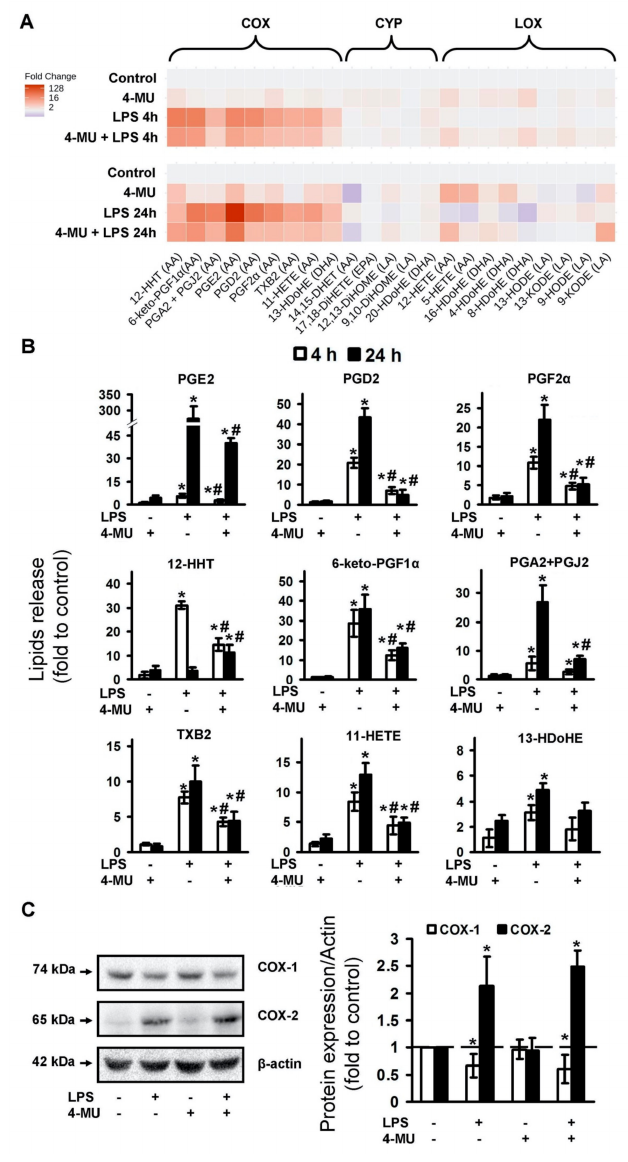
Figure 2. E ff ect of 4-methylumbelliferone (4-MU) on the oxylipins release and cyclooxygenases expression in the LPS-stimulated astrocytes. Primary rat astrocytes were pretreated for 30 min with 4-MU (400 µ M) and then stimulated with lipopolysaccharide (LPS, 100 ng / mL) for 4 h or 24 h. Concentrations of oxylipins in supernatants were measured using ultra-performance liquid chromatography-tandem mass spectrometry (UPLC-MS / MS). ( A ) The heat map shows relative amounts of each lipid mediator compared to the control. The vertical axis indicates the stimuli, while the horizontal axis indicates the relative amount (log2) of each lipid mediator. Metabolites were divided into: Lipoxygenase (LOX), cyclooxygenase (COX) and cytochrome (CYP) pathways involved in their synthesis. ( B ) The bars show relative amounts of COX-derived lipid mediators. ( C ) COX-1 and COX-2 protein levels were evaluated by western blotting and normalized to the loading control β -actin. The example is representative for three independent experiments. Values represent the mean ± SEM from three independent experiments. * p < 0.05, compared with the unstimulated cells, # p < 0.05, compared with the LPS-stimulated